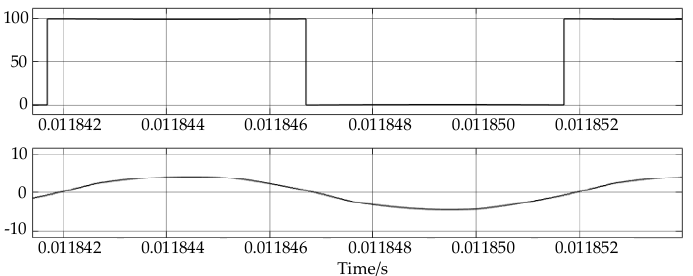
Figure 28. φ AD = 92° and φ AB = 239° bridge-arm B drain-source voltage and current waveforms.